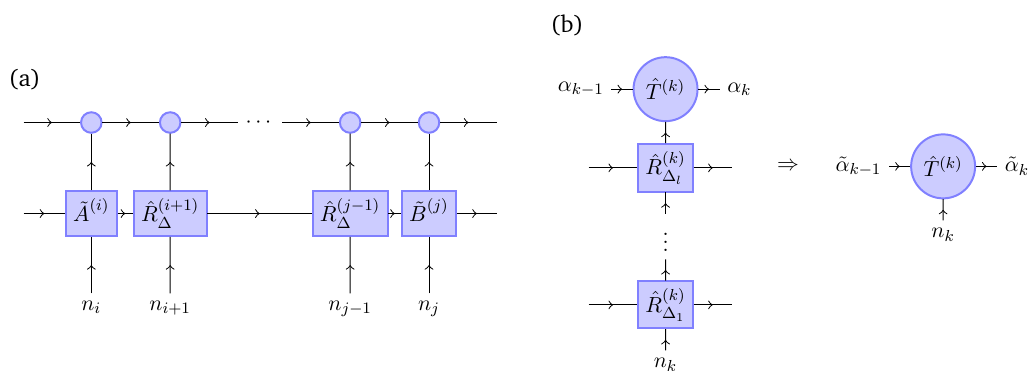
Figure 2: (a) MPO representation of the U ( 1 ) -invariant operator expression ˆ A ( i ) ˆ B ( j ) with shift ( k ) tensors ˆ R mediating the shift in the auxiliary-bond quantum numbers. (b) Network of var- ∆ ious shift tensors applied to the U ( 1 ) -invariant site tensor ˆ T ( k ) before and after performing the contractions, respectively. After contraction, the auxiliary block indices are given